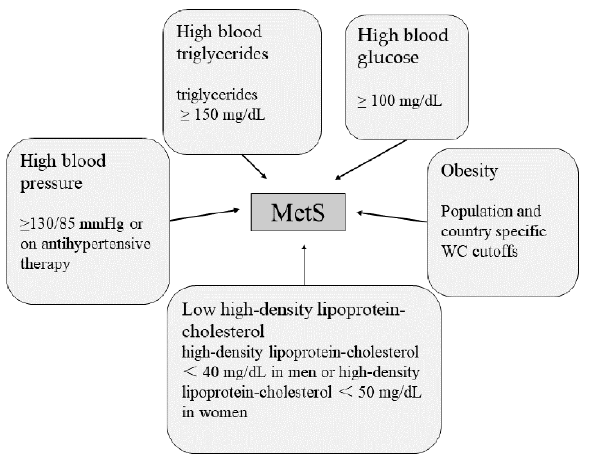
Figure 1. Main diagnosis of MetS. Three of the above five conditions are considered MetS [8].